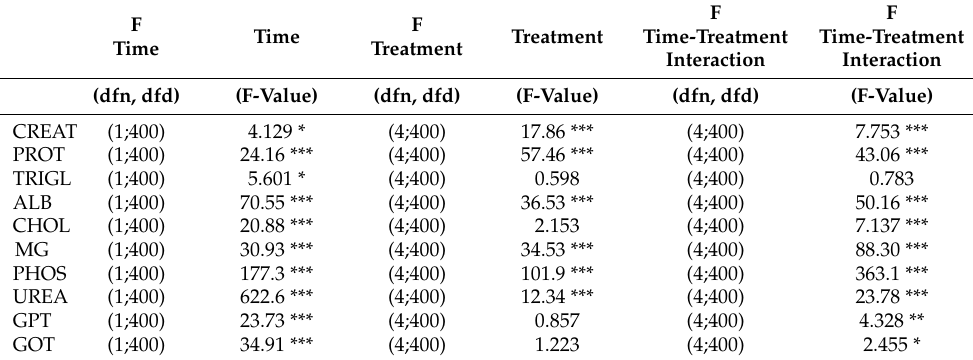
Table 2. Results of two-way ANOVA of time (T1—15 days; T2—30 days), treatment (A: con- trol; B: 0.5%; C: 1%; D: 2%; E: 3% w / w F1-BEO) and interaction (time × treatment) on serum blood paraments in rainbow trout ( Oncorhynchus mykiss ). Degrees of freedom (dfn = numerator, dfd = denominator) and F statistics (F) are provided. Asterisks denote significant differences: *** p < 0.001; ** p < 0.01; * p < 0.05. ALB denotes albumin; CHOL cholesterol; CREA